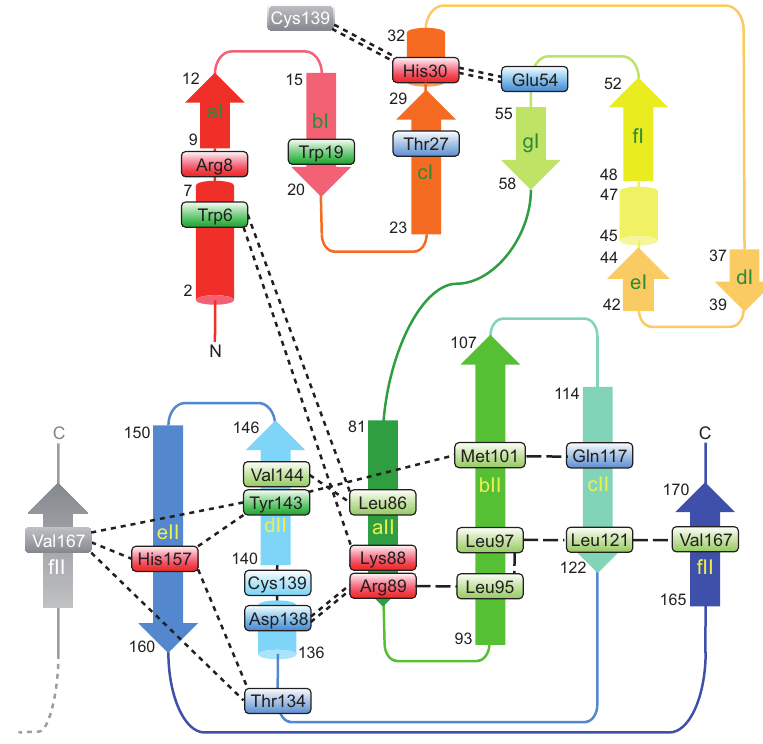
Figure 3 Map of amino acid residues important for proteolytic activity and/or stability. Important residues identifi ed in these mutagenesis studies are mapped on the topological view of the 3C-like protease. A dashed line between two residues indicates that the two residues are close to each other. A double dashed line indicates an ionic interaction. The triplet Cys139- His30-Glu54 constitutes a catalytic triad for proteolysis, although Glu54 is not essential. Arg89 was salt-bridged with Asp138. For clarity, the Cys139 residue and the fII β sheet are represented in two different